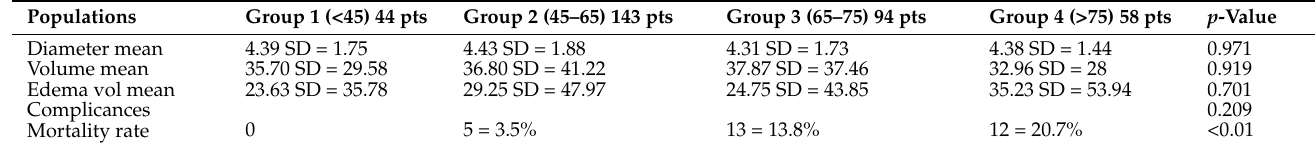
Table 2. Principal analysis of radiological and outcome data performed on four age